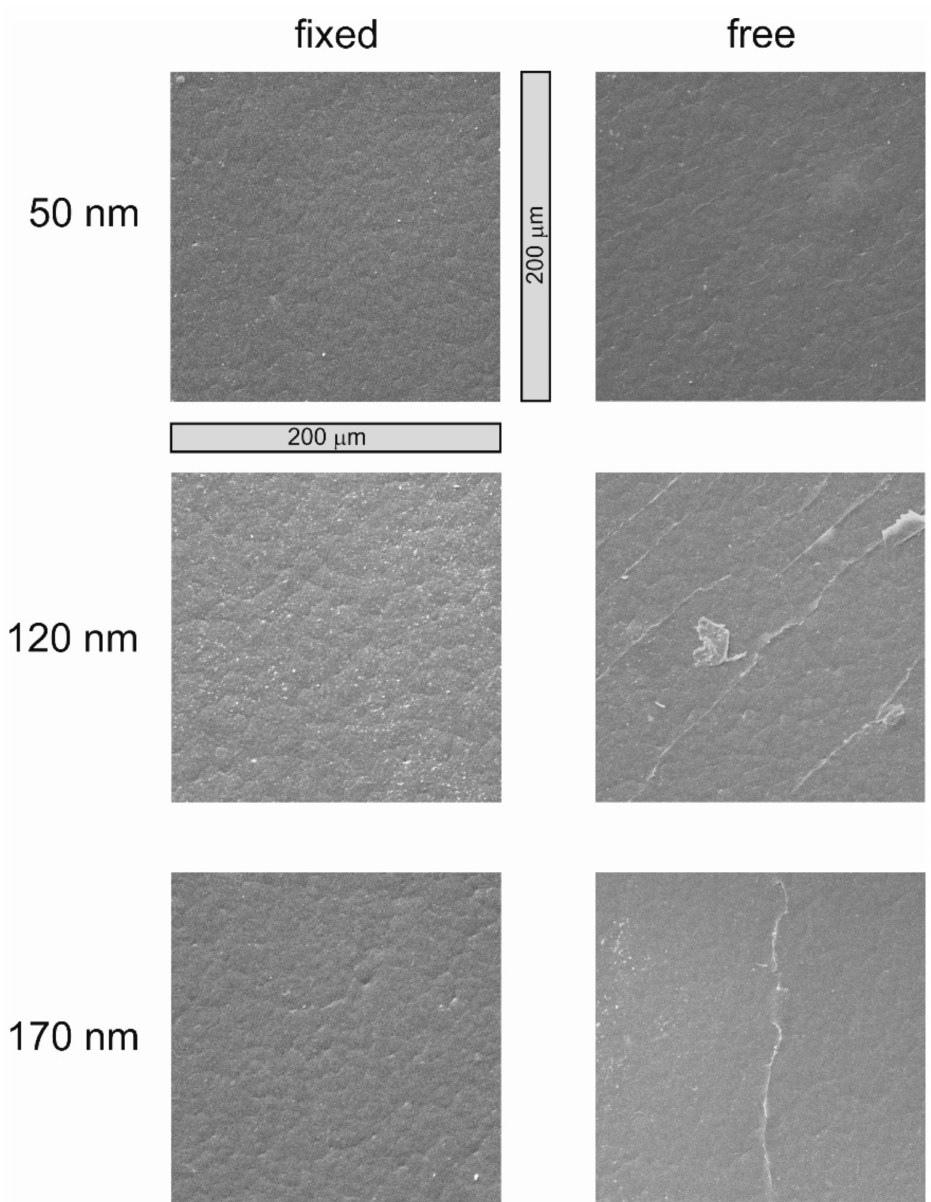
Figure 4. SEM analysis of a-C:H layers on PHB with thicknesses from 50, 120 and170 nm. On the left are the “fixed” samples and on the right the “free”